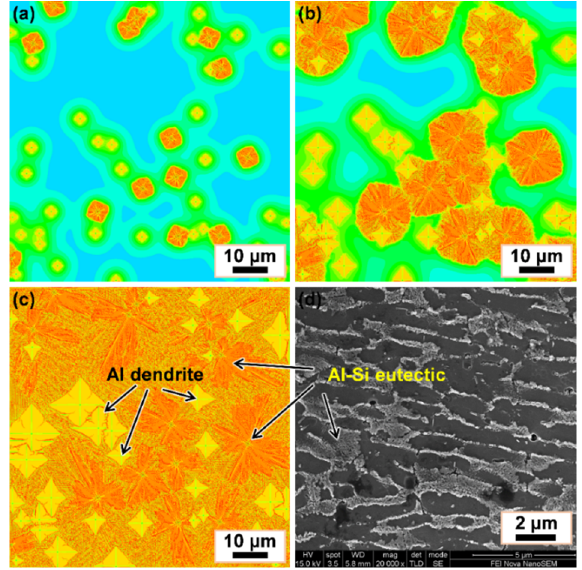
Figure 7. Simulation results of Al-Si eutectic evolution with a eutectic undercooling ∆ T e = 10 K for various times and experimental result: ( a ) t = 0.5 s; ( b ) t = 1 s; ( c ) t = 2.2 s; ( d ) SEM micrograph of eutectic morphology.